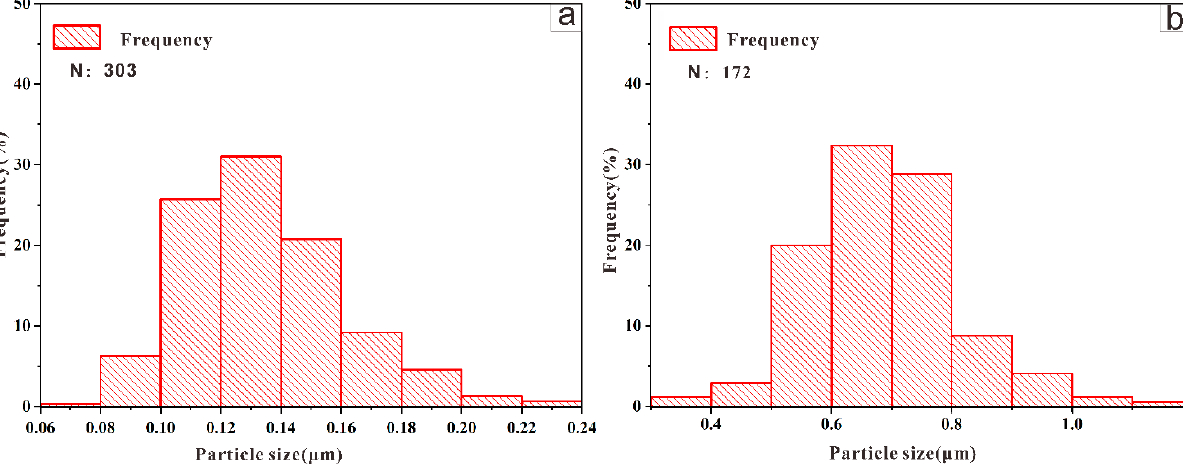
Figure 5. Histograms of barite particle size synthesized using a mixed solution of 0.1 mol/kg Na 2 SO 4 and BaCl 2 ( a ) and a mixed solution of 0.03 mol/kg Na 2 SO 4 and BaCl 2 ( b ) with a mixing ratio of 1:1 at room temperature. N: statistic.